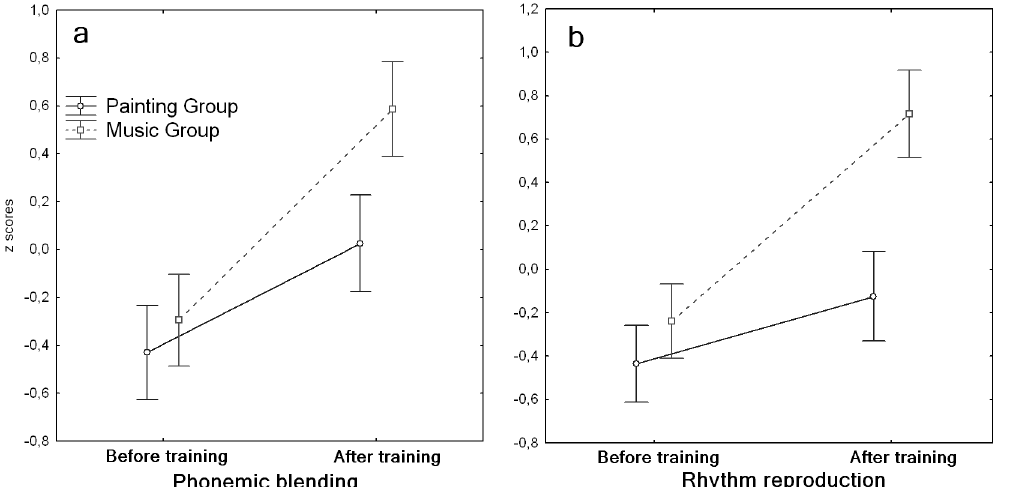
Fig 2. Effects of music and painting training on accuracy in the phonemic blending (a) and rhythm reproduction (b) tasks, before and after training. Error bars indicate the standard error of the mean. Values are z-score normalized.